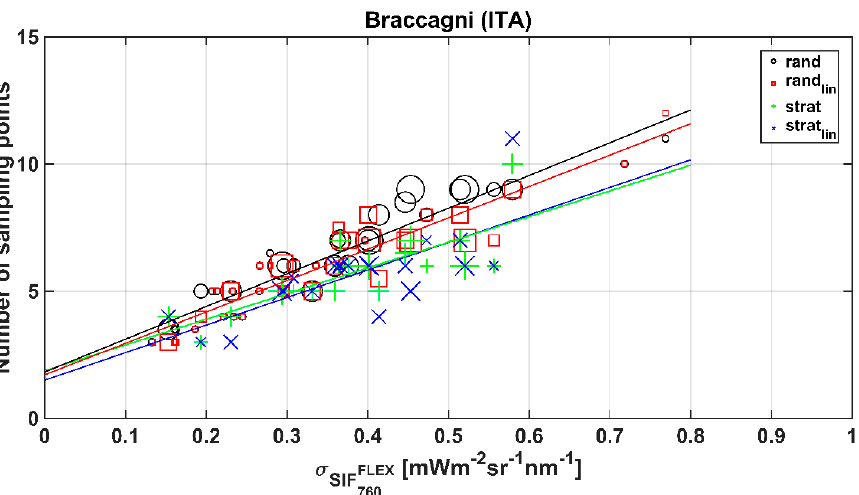
Figure 7. The 95th percentile of the number of sampling points needed to meet the T10 thresholds for the FLEX pixels in Braccagni (Italy) experimental site using a random sampling, a random sampling with a linear combination model, a stratified random sampling and a stratified random sampling with a linear combination model. The number of sampling points is shown in relation to σ (cid:2903)(cid:2893)(cid:2890) (cid:3123)(cid:3122)(cid:3116)(cid:3138)(cid:3144)(cid:3137)(cid:3156) . The pointer size is related to the number of components within each FLEX pixel (1–3). The solid lines show the linear OLS regressions for each sampling strategy.